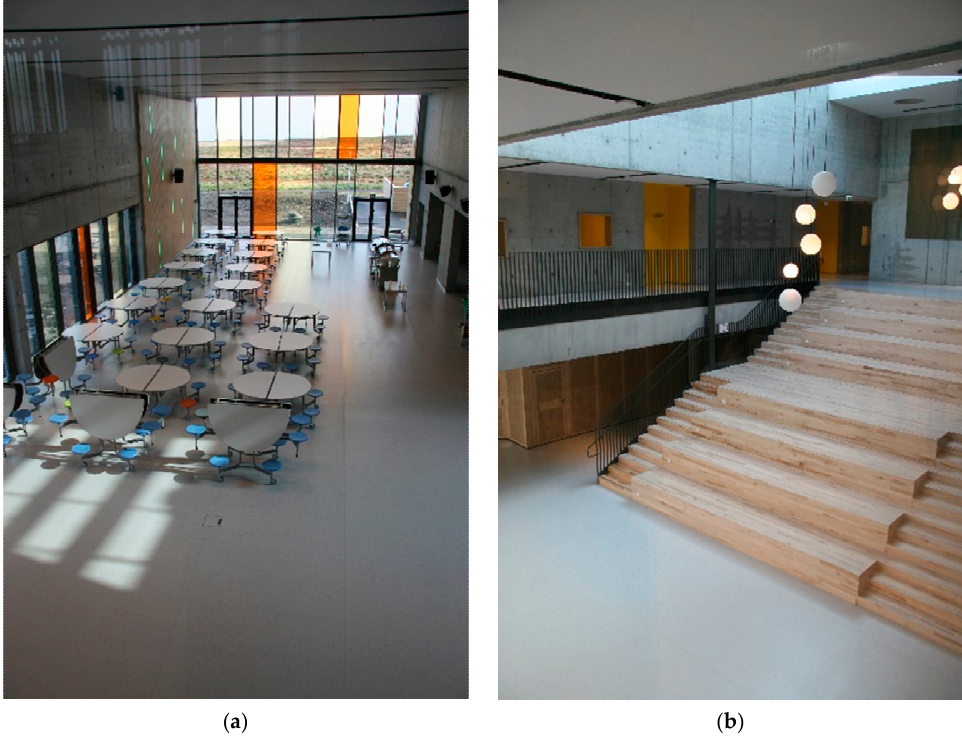
Figure 2. The assembly hall. ( a ) View from above to the north. An extension for sports will be built on the left side. An adjoining kitchen and a lower hall lie hidden to the right. ( b ) Balconies and giant steps are used to accommodate audiences and walls on the lower floor can be removed.